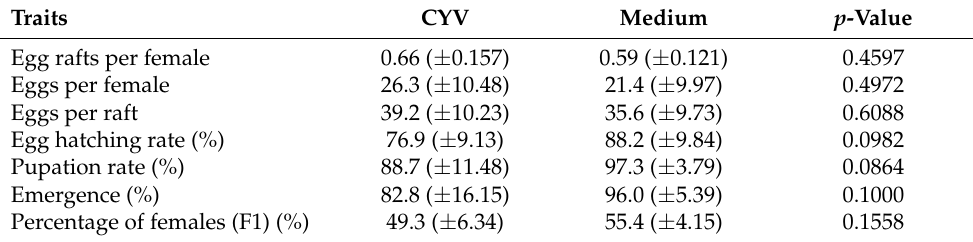
Table 2. Summary of various reproductive traits comparing CYV- and medium-injected Cx. pipiens biotype molestus females with SD. For parametric data, the unpaired t -test was performed to determine p -values; p -values of non-parametric data were determined using the Mann–Whitney